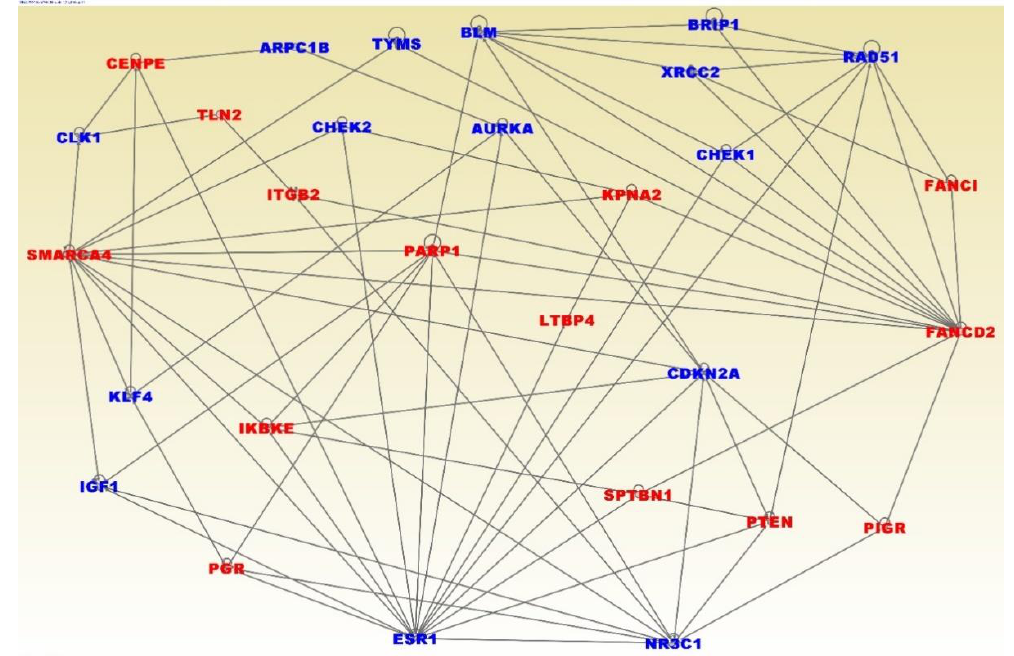
Figure 6. Network analysis showing interactions and functional relationships among and between the genes containing germline mutations only and genes containing somatic mutations only. Genes in blue contain germline mutations and genes in red fonts contain somatic mutations and were all significantly differentially expressed between patients with TNBC and controls.